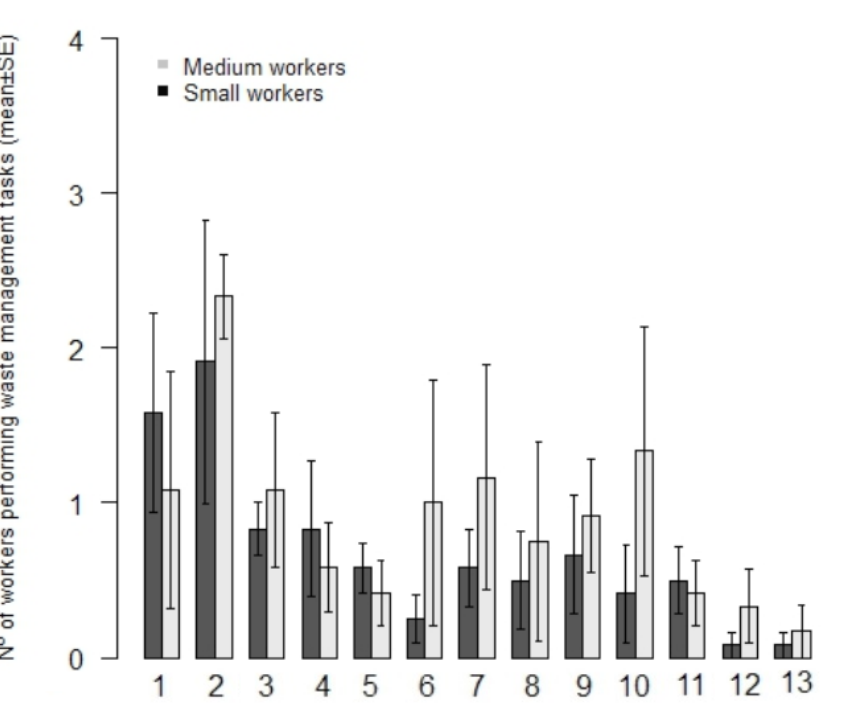
Fig 3 . Number of medium and small-sized workers (mean ± SE) performing waste management each week.